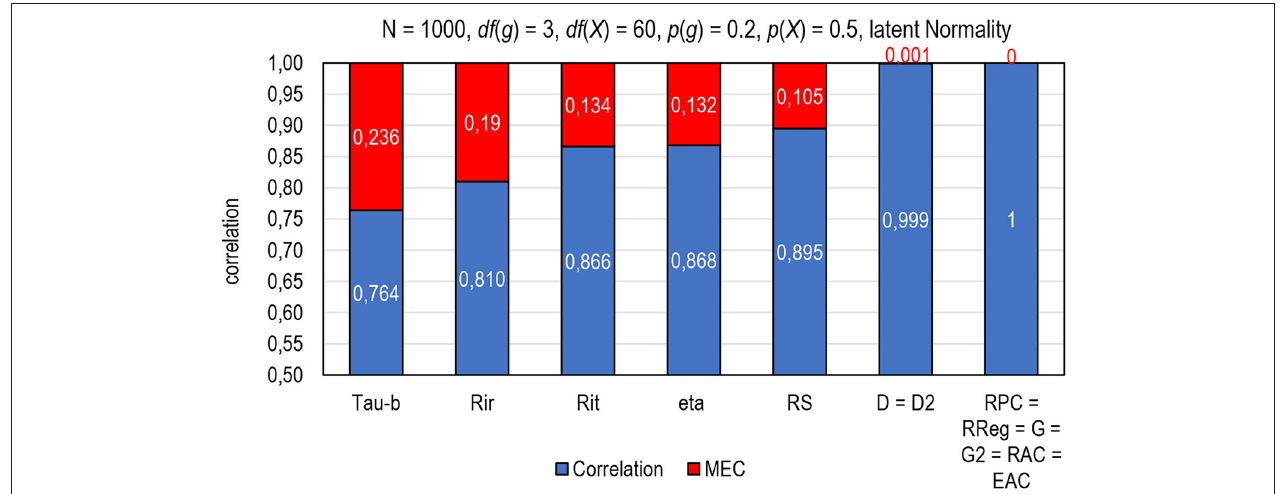
FIGURE 1 | The magnitude of a mechanical error on the estimates of correlation (MEC) by selected estimators of correlation. Tau-b item–rest correlation ( Somers delta (X-dependent); D2 dimension-corrected G, RAC